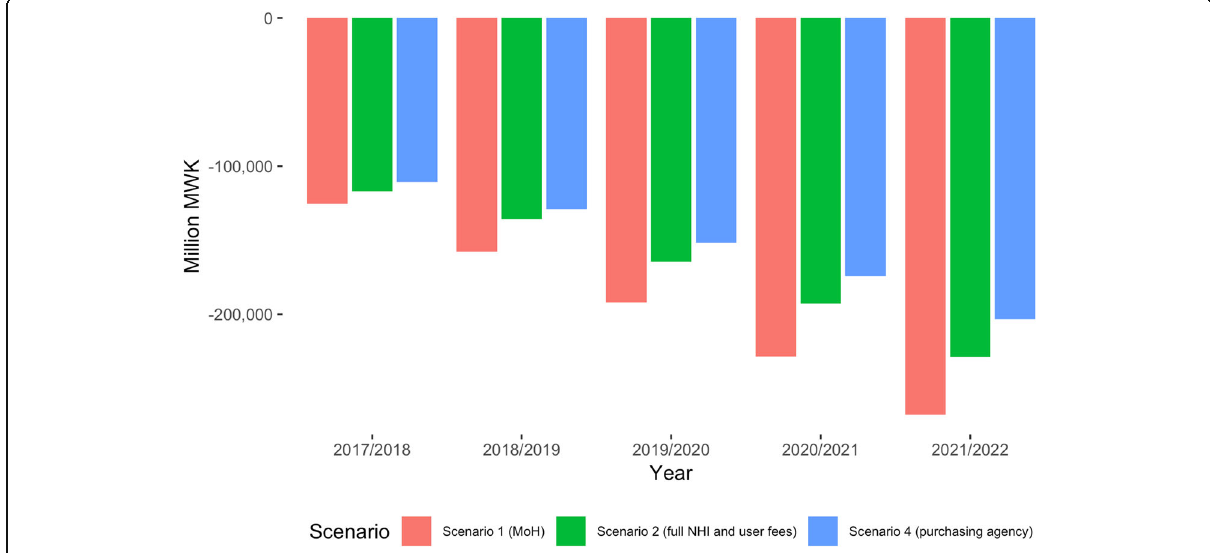
Fig. 2 Impact of reform scenarios on the health financing